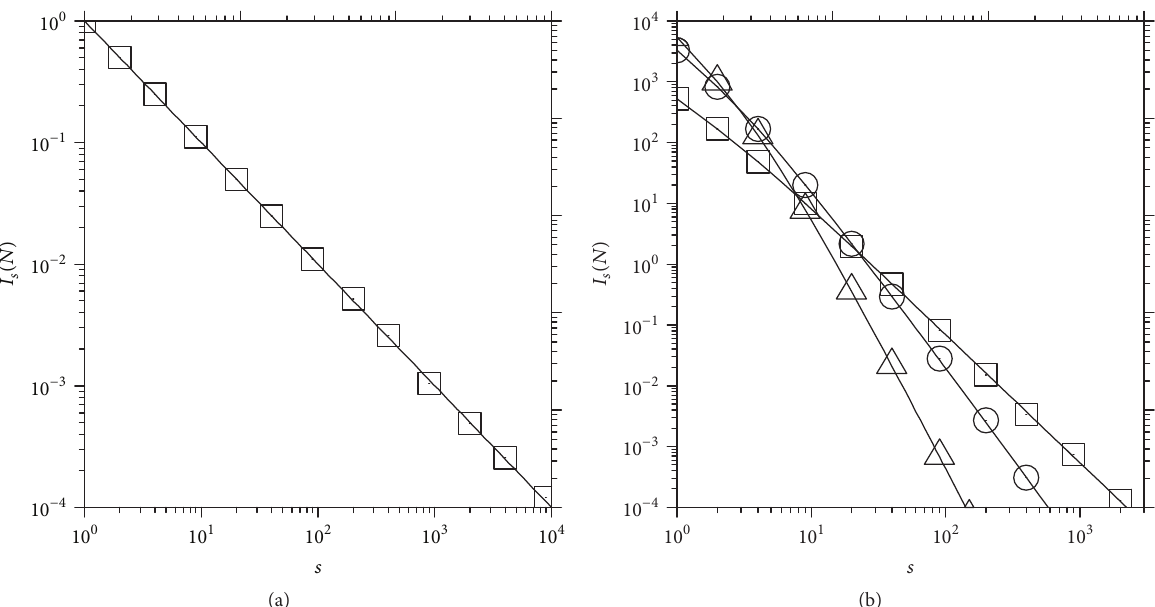
Figure 3: Comparison of the islands size distributions obtained numerically (symbols ⊡ ⊙ Δ ) and the analytical results (solid lines) as a function of the island size 𝑠 . (a) Equation (7). (b) Equation (13) with 𝑝 = 0.1, 0.5 , and 0.7 .